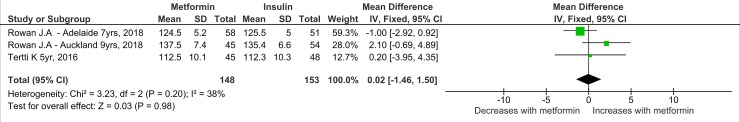
Childhood height.Expressed as mean differences (fixed effects model) and 95% CI. IV, mean difference.